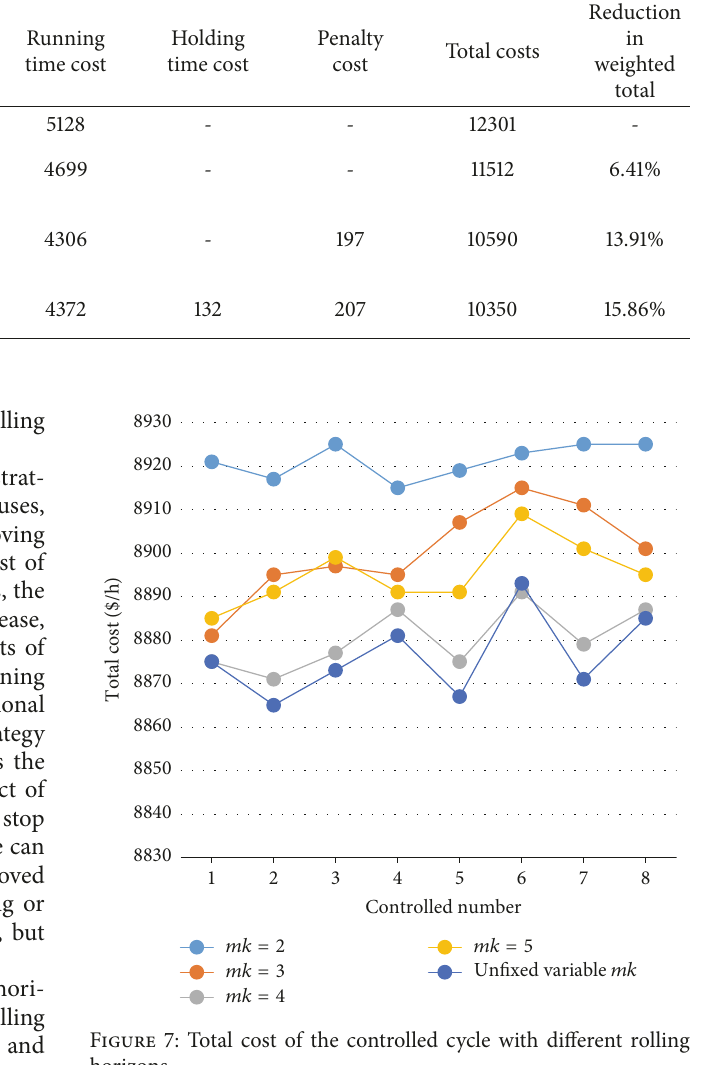
Table 1: Effects of the proposed dynamic approach.